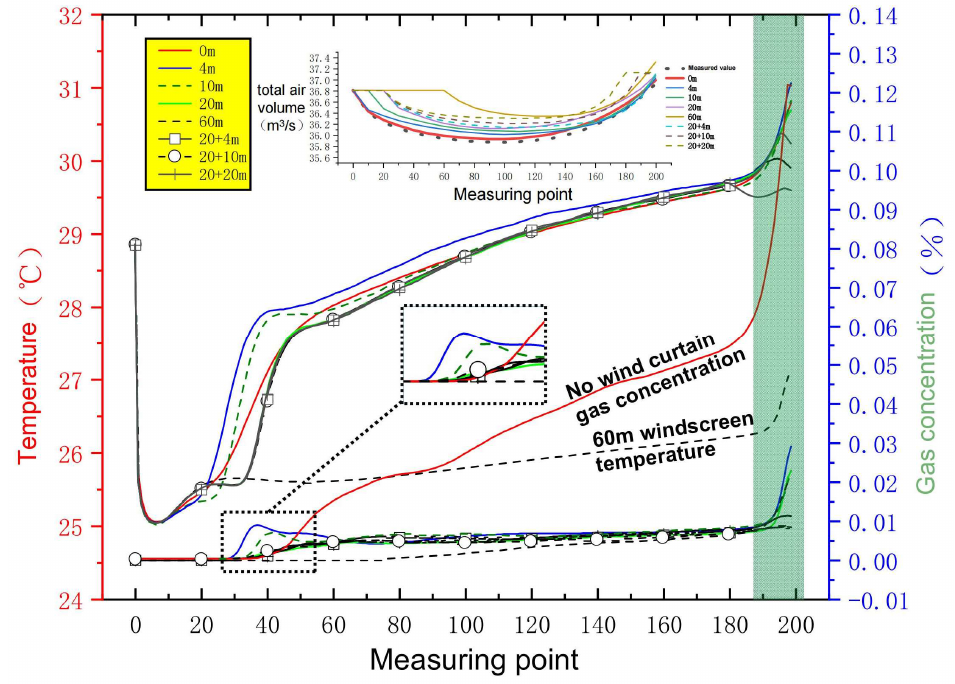
Figure 10. Data curve of working face with different air curtain